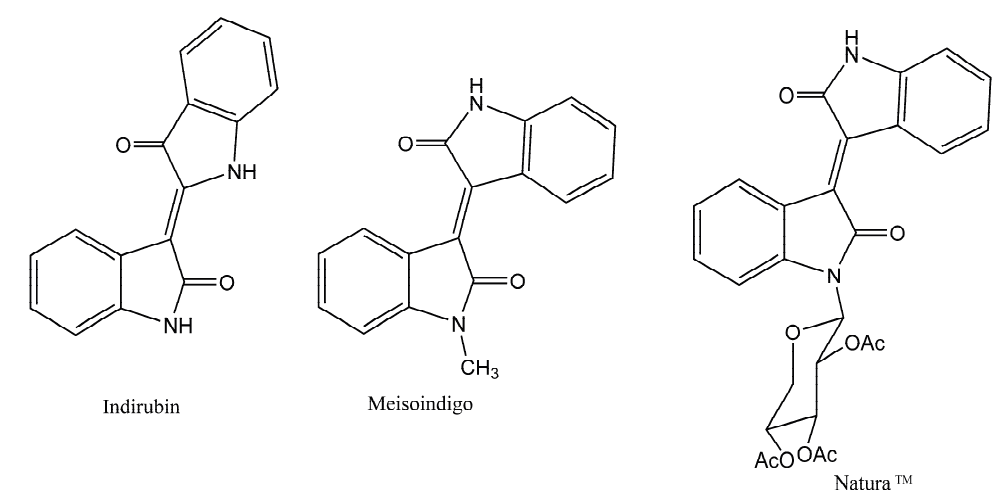
Figure 1. Structures of indurbin, meisoindigo and Natura TM